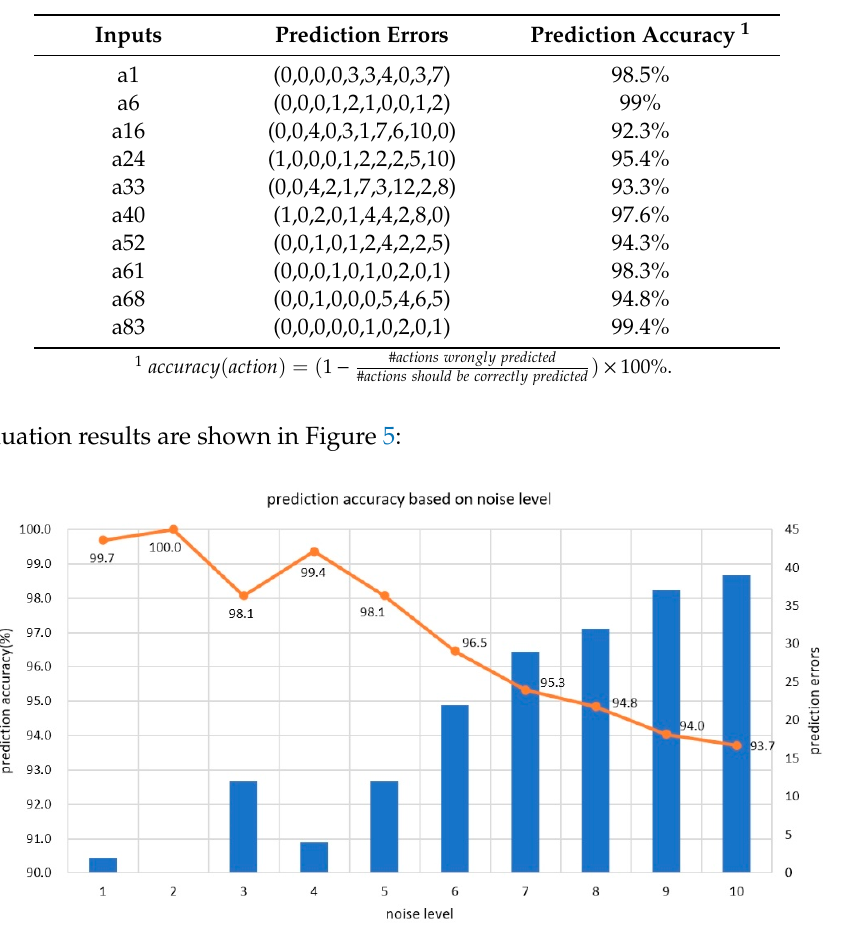
Figure 5. The prediction accuracy based on different noisy levels.